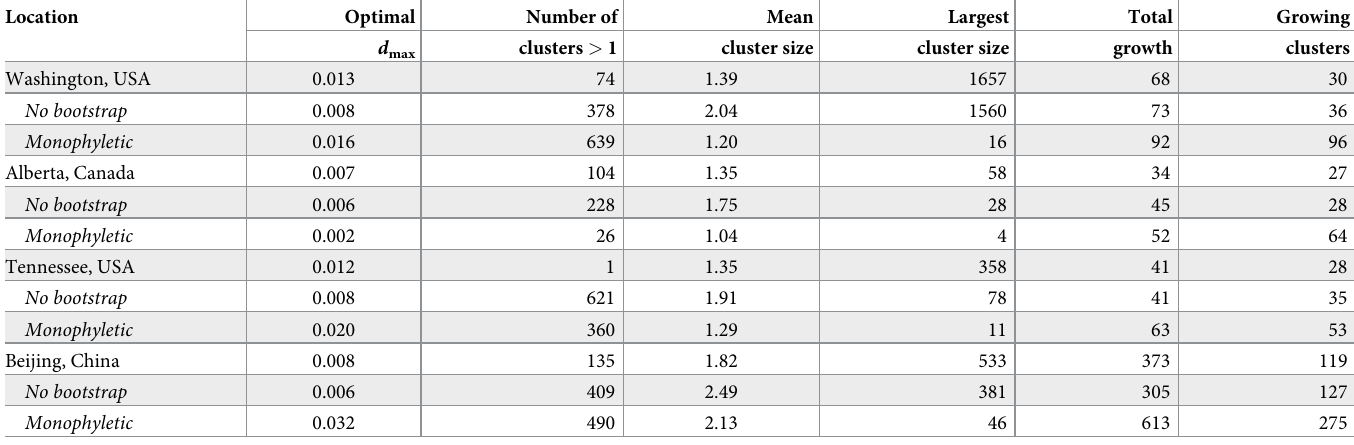
Table 2. Cluster statistics under paraphyletic and monophyletic clustering. ‘No bootstrap’ corresponds to paraphyetic clustering with b min = 0; otherwise this threshold defaults to 95%. Optimal d max is the pairwise distance threshold selected by minimizing Δ AIC, in units of expected number of nucleotide substitutions. ‘Number of clusters’ only counts clusters with two or more background sequences, i.e. , this number does not include singletons. Total growth is the number of incident (new) sequences con- nected to clusters of background sequences. Growing clusters is the number of clusters to which incident sequences attach.